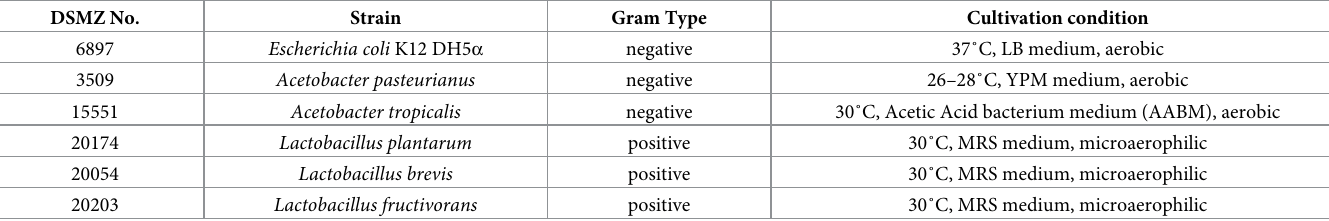
Table 2. Bacterial strains used in the present study. DSMZ